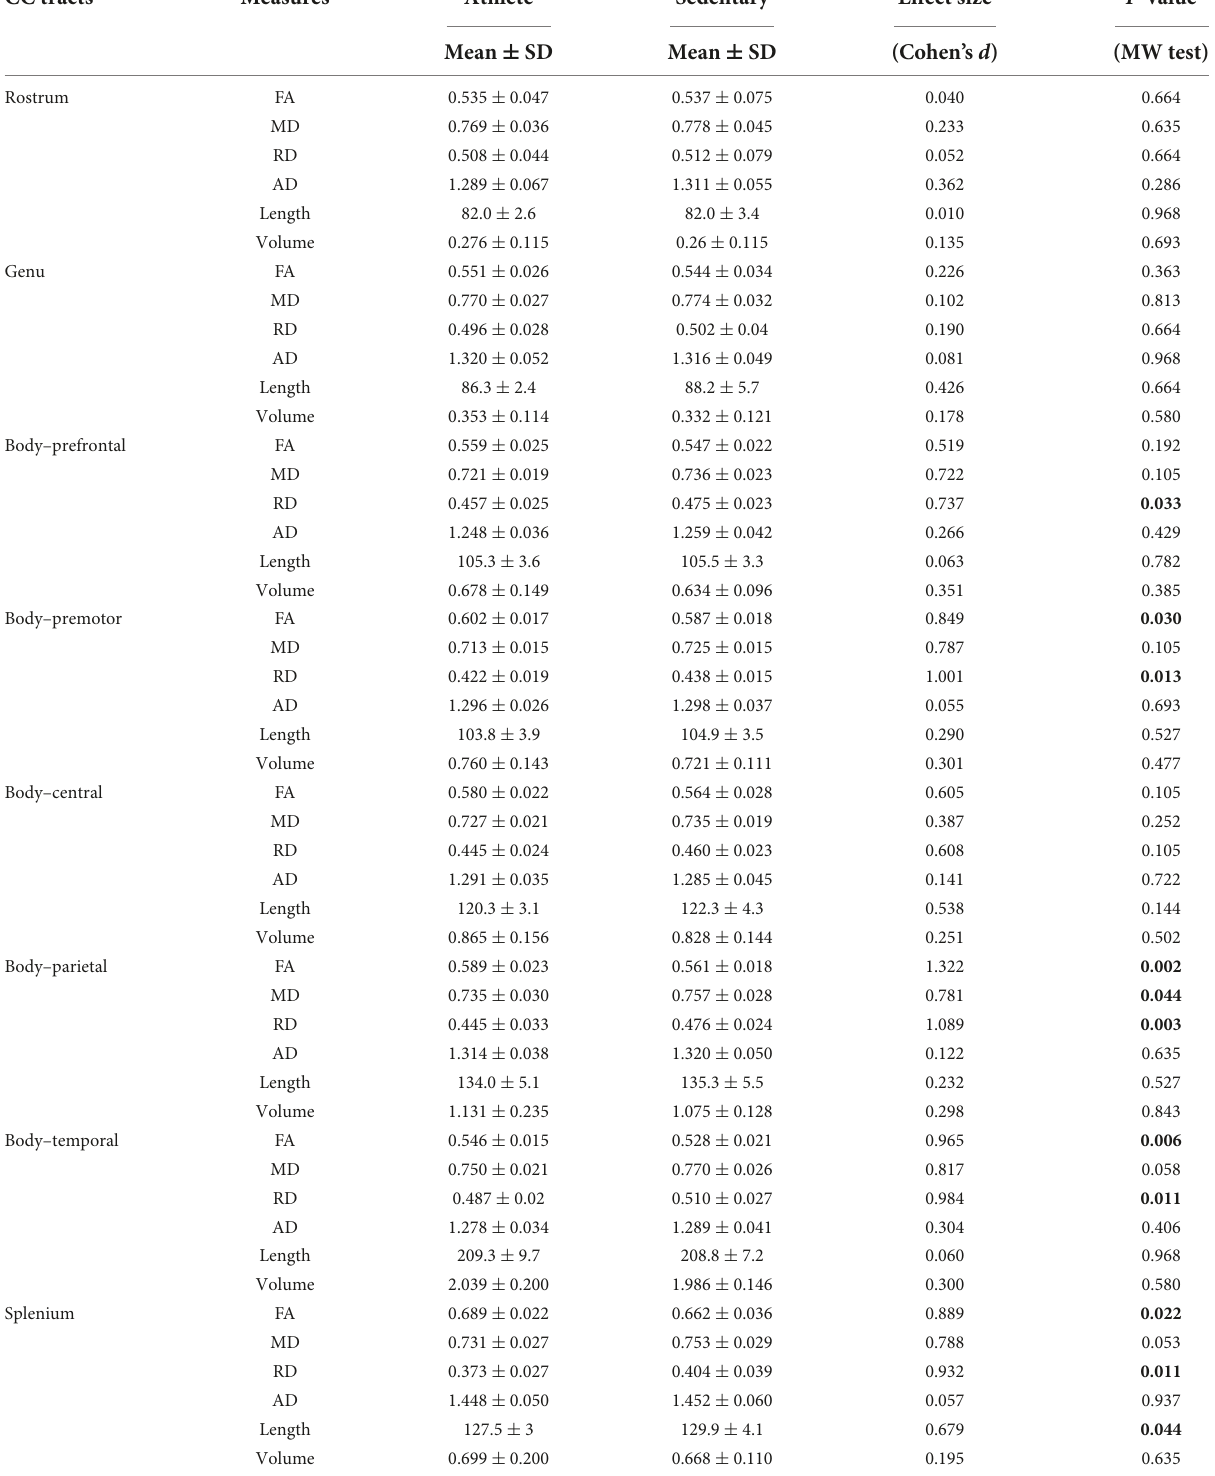
TABLE 2 Microstructural and morphometric measures of the corpus callosum (CC) tracts computed from the TRActs Constrained by UnderLying Anatomy (TRACULA) in the athlete and sedentary groups. CC